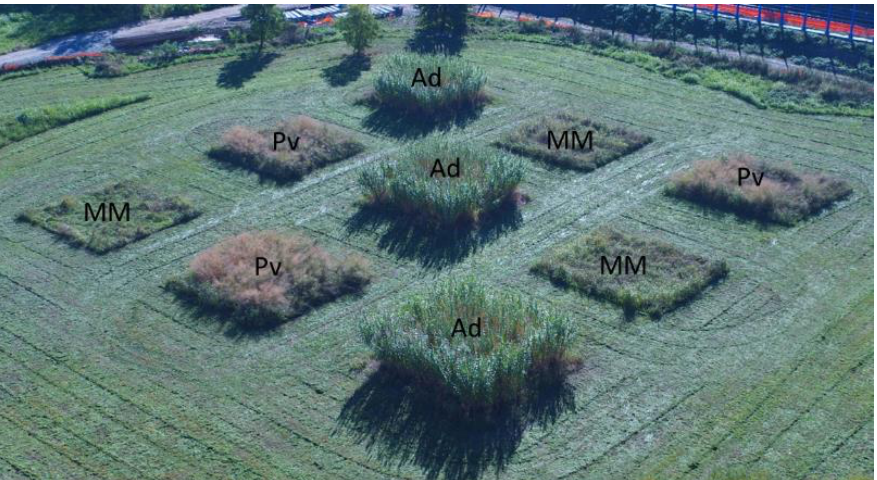
Figure 1. Experimental field photographed from the air during the period of this study. The letters represent the different species used: A. donax (Ad); switchgrass (Pv) and mixed meadow (MM). Each block has the dimensions of 10 m × 10 m with a distance of 10 m between the plots. The grass between the plots was regularly mown, to avoid growth of surrounding weeds.